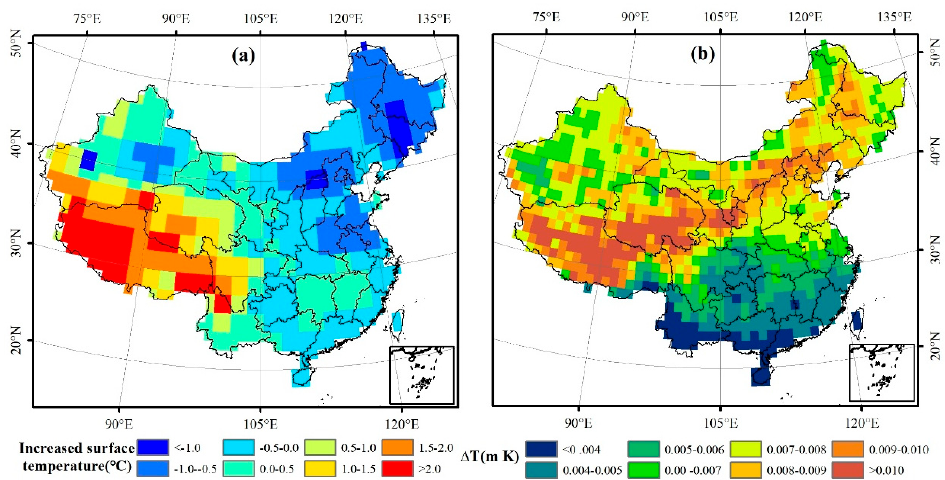
Figure 8. ( a ) The increased surface temperature from 2002 to 2016; ( b ) the estimated surface temperature response for a 20-year time frame.